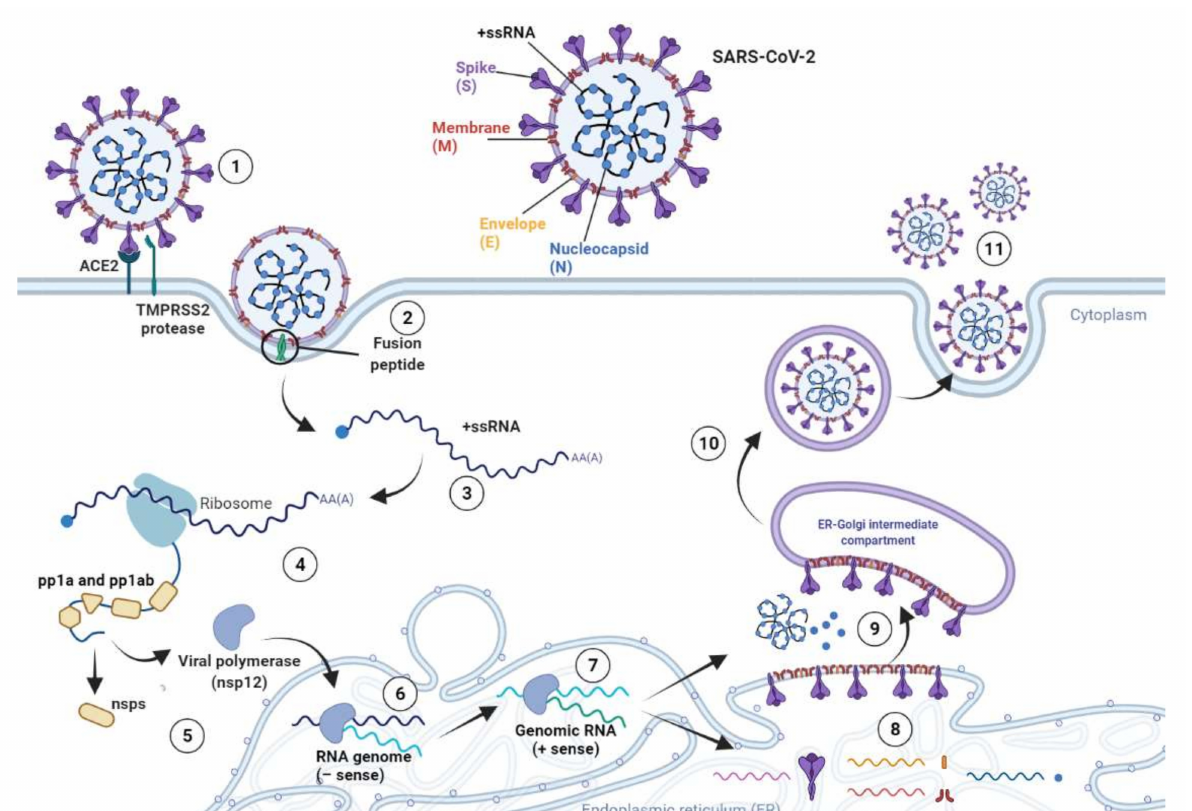
Figure 2. SARS-CoV-2 life cycle. ( 1 ) Binding between S glycoprotein and ACE2 receptor on the surface of host cell. ( 2 ) The fusion peptide undergoes conformational changes allowing SARS-CoV-2 fusion and entry into the cell cytoplasm. ( 3 ) Release of SARS-CoV-2 single-stranded positive RNA genome. ( 4 ) Viral genome is immediately transcribed by host cell ribosomes. ( 5 ) The translated RNA encodes polyproteins (pp1a and pp1ab) and the viral RNA-dependent RNA polymerase NSP12. ( 6 ) NSP12 produces full-length negative-sense copies of SARS-CoV-2 RNA. ( 7 ) The negative-sense RNA genome is employed as a template for generating the new positive-sense genomes. ( 8 ) The translation of the viral RNA occurs in the endoplasmic reticulum of host cells and leads to the synthesis of structural proteins. ( 9 ) Structural proteins move into the Golgi intermediate compartment where viral assembly occurs. ( 10 ) The mature viral progeny germinates from the intermediate compartment of the Golgi, and it is released as secretory vesicles. ( 11 ) SARS-CoV-2 virions are secreted by